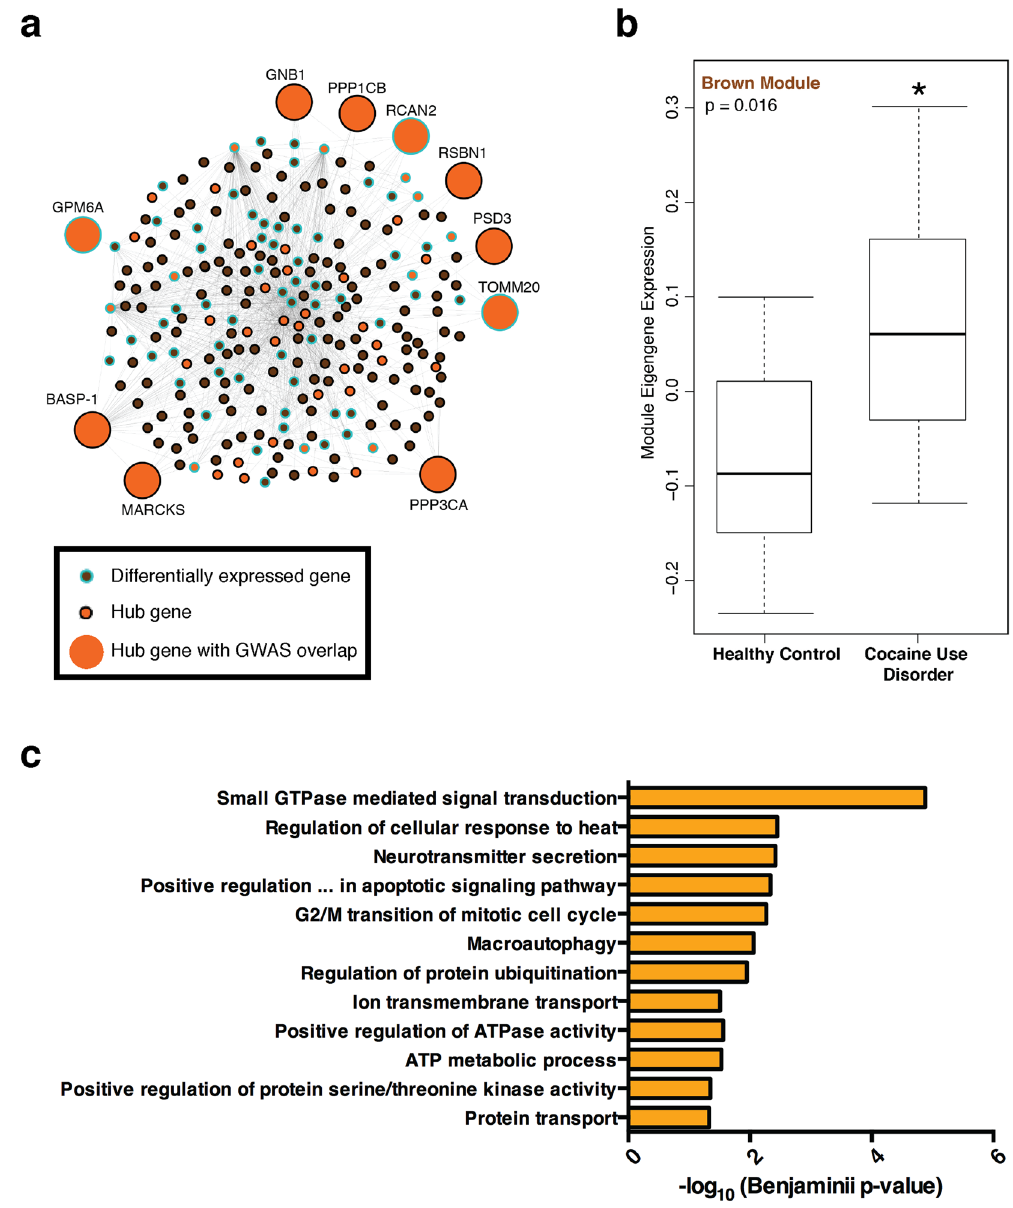
Figure 4. Brown module expression is increased in human dlPFC neurons from cocaine addicts. ( a ) Network diagram of brown module containing 550 transcripts, each shown as an individual node. Lines between nodes connect highly co-expressed transcripts within our dataset (threshold: k > 3). Orange nodes show Hub genes, defined as the top 10% most connected transcripts. Differentially-expressed transcripts are outlined in blue (p < 0.05). The larger nodes highlight differentially expressed hub genes that are hits in genome-wide association studies (GWAS) for several neuropsychiatric disorders (see text). ( b ) Mean eigengene expression is significantly increased in dlPFC neurons from cocaine cases compared to controls (Kruskal-Wallis test: p < 0.02). ( c ) Transcripts in the brown module are significantly enriched for several distinct biological processes related to neuroplasticity. We used the DAVID bioinformatics resource to identify biological processes enriched in the brown module. Each bar denotes the − log 10 Benjamini p-values a specific Gene Ontology term. All biological process terms that achieved significance (benjamini p < 0.05) are